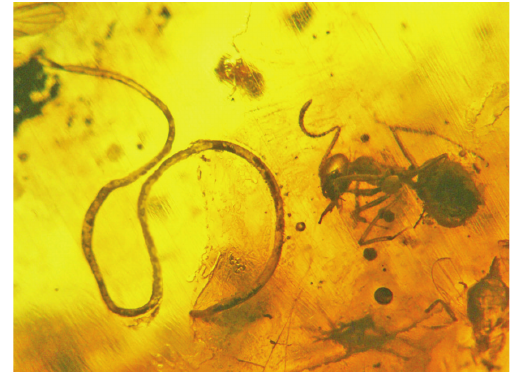
Figure 4: Heydenius formicinus adjacent to its worker ant host in Baltic amber.